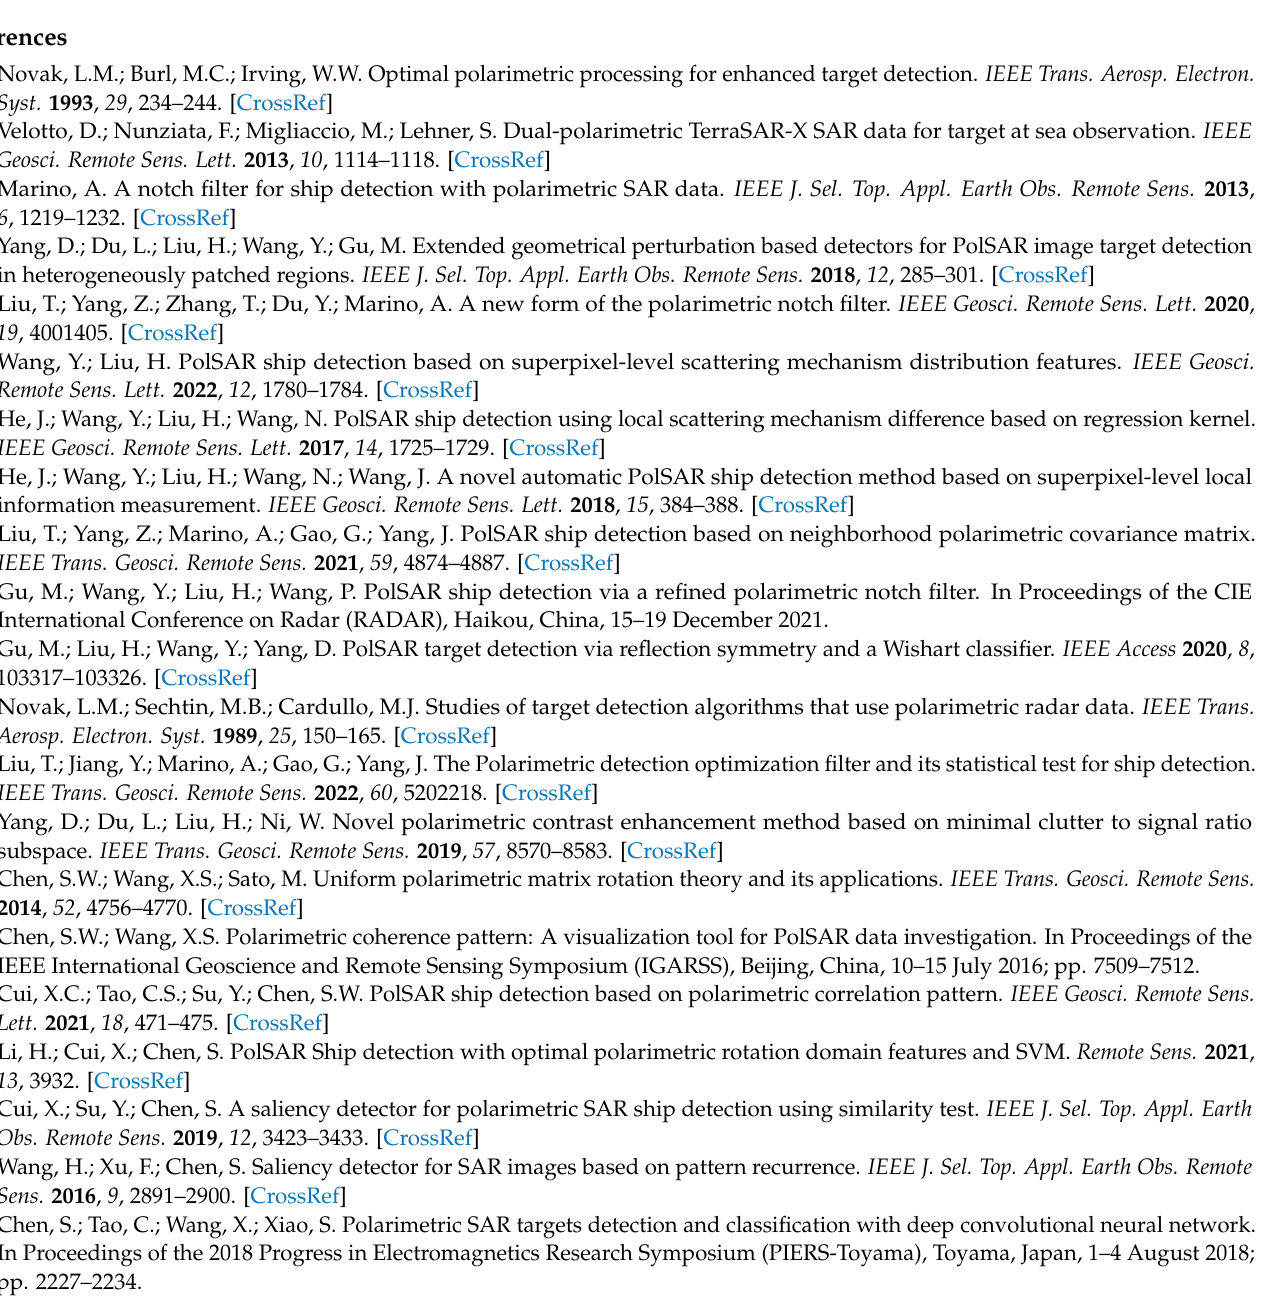
The two data sets used in this paper are both under low- and middle-sea conditions. The method should be validated on more data with complex sea conditions in the future, with a view to identifying deficiencies and improving